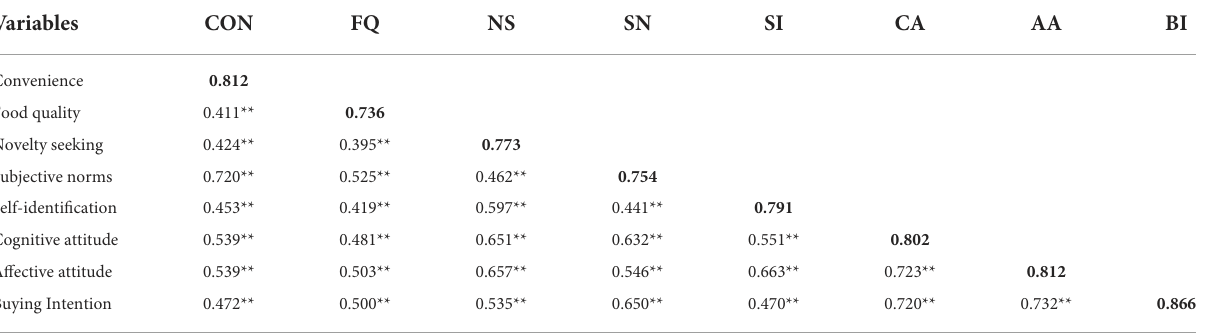
TABLE 2 Discriminant validity of the first-order construct.